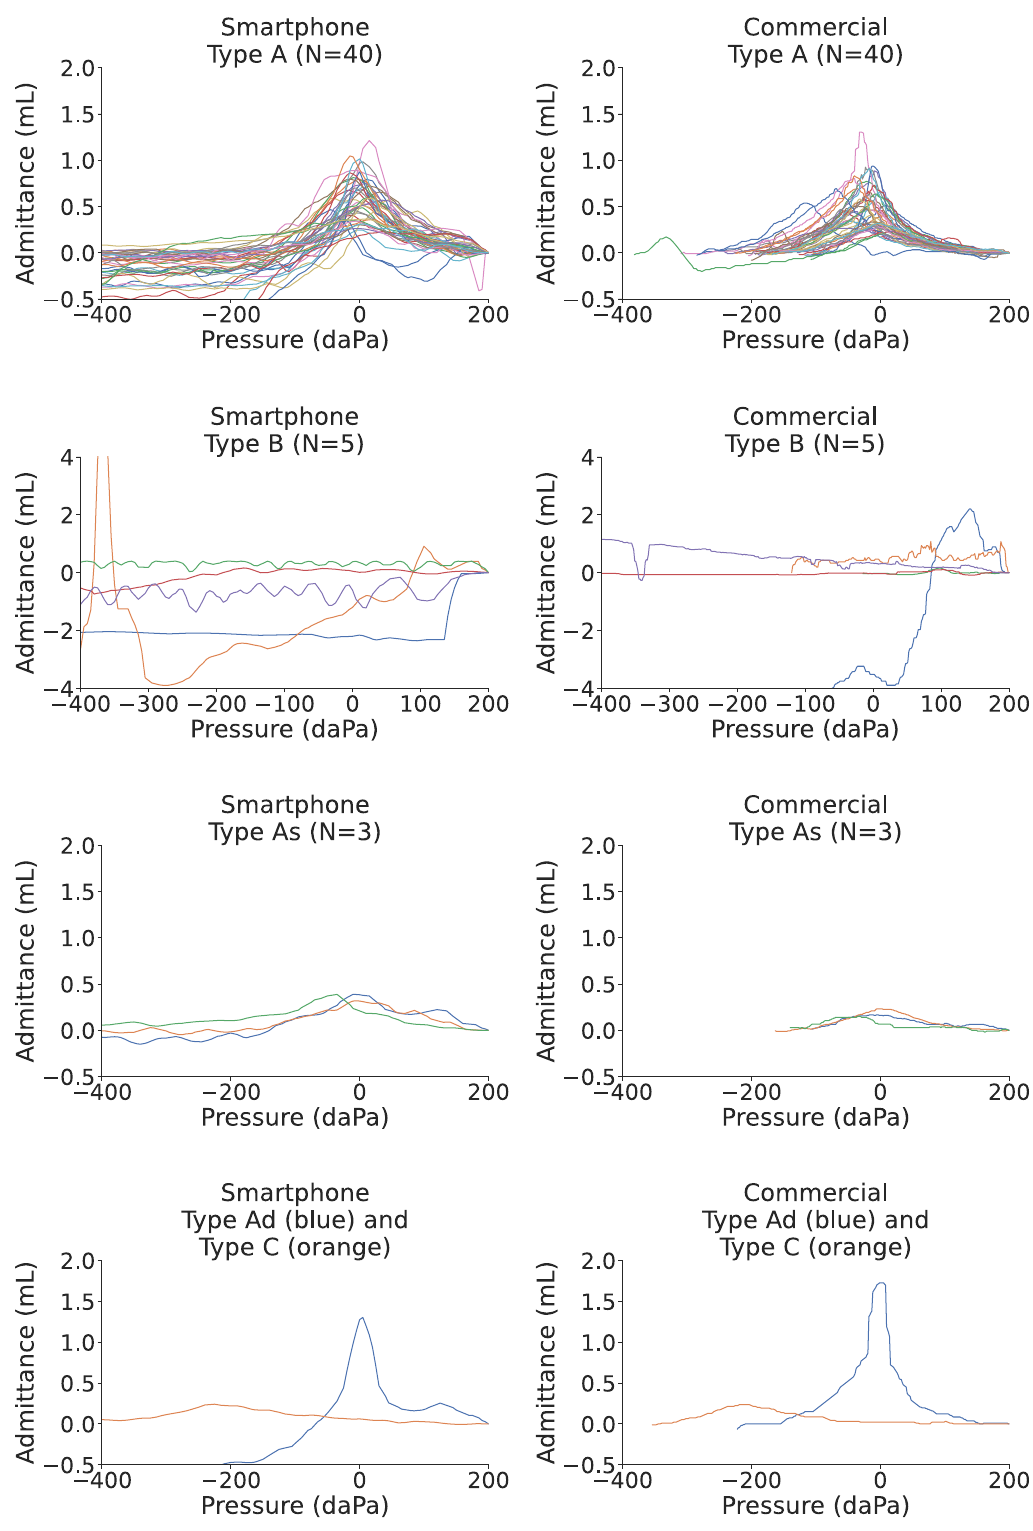
Fig. 4 Comparison of individual tympanograms from smartphone-based and commercial tympanometer. We show the plots for 40 type A, 5 type B, 3 type As, 1 type Ad, and 1 type C tympanograms measured by the commercial tympanometer, and tympanograms from the same ear as obtained by the smartphone-based tympanometer. Source data are provided in Supplementary Data